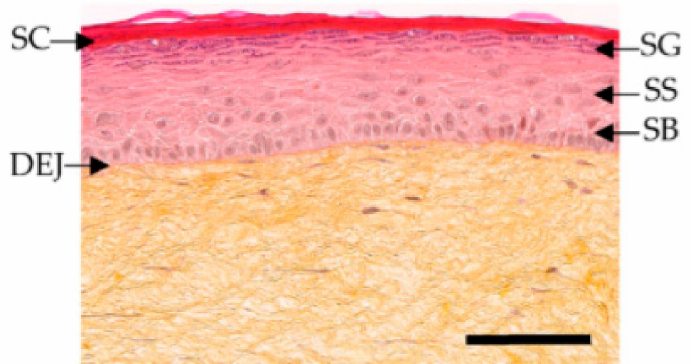
Figure 6. Histological stained images of T-Skin™, with stratum corneum (SC), stratum granulosum (SG), stratum spinosum (SS), stratum basale (SB), and dermoepidermal junction (DEJ). Reproduced with permission from